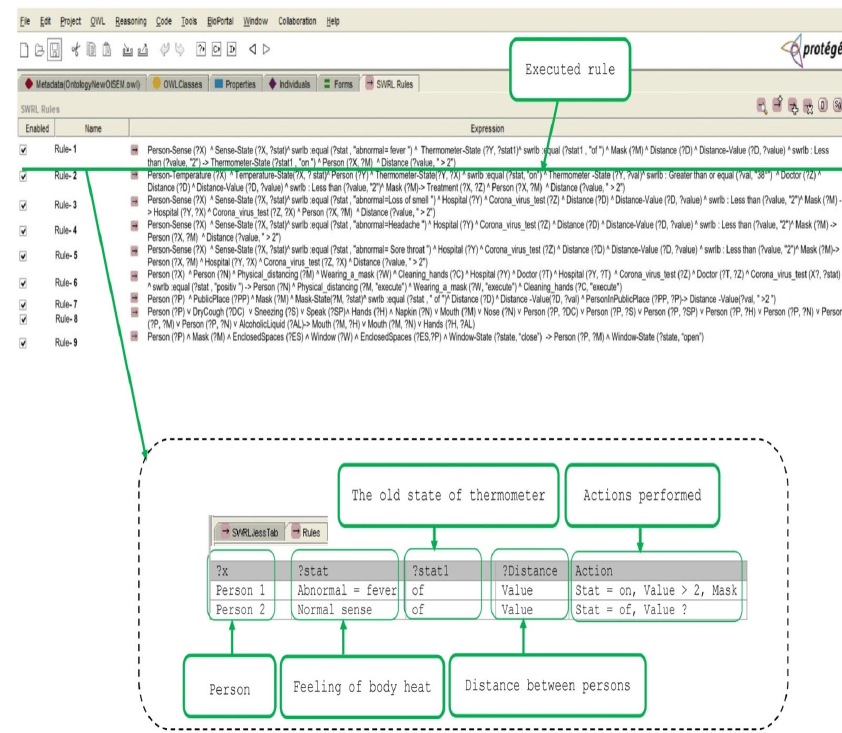
Figure 4. Results of the first scenario.